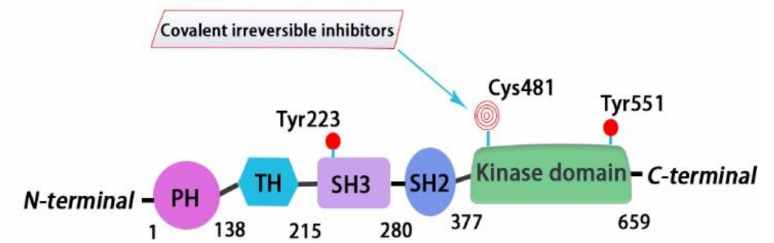
Figure 1. Bruton’s tyrosine kinase (BTK) structure diagram. BTK is composed of 659 amino acids and contains five domains. From N-terminal to C-terminal, domains are listed as the pleckstrin homology (PH) domain, proline-rich TEC homology (TH) domain, SRC homology domains SH3 and SH2, and the catalytic kinase domain. Currently, six approved BTK inhibitors target the kinase domain of BTK, forming a covalent bond with